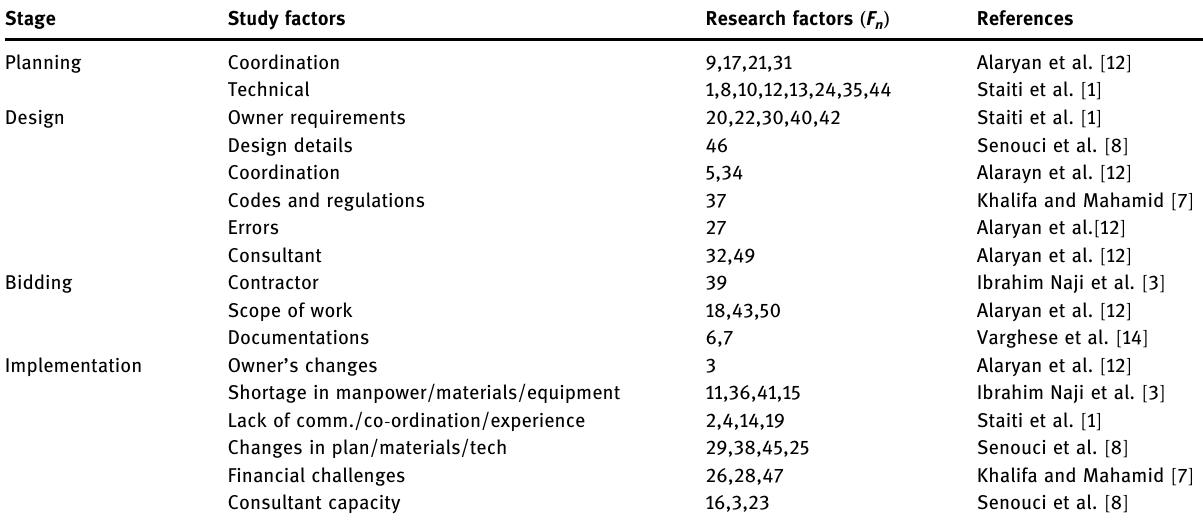
Table 4: Comparison of current research methodology results with previous studies Stage Study